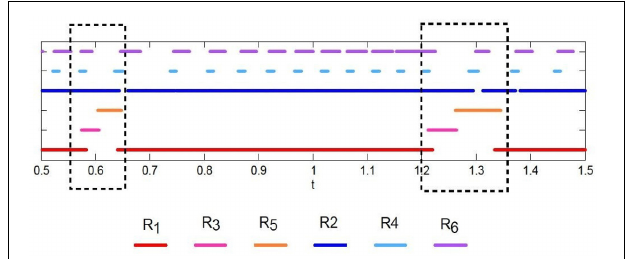
FIGURE 6 | Schematics of the trajectory of a pathological case of GLV equations, when the initial sequence enters a chaotic valley after the violet unit. The system stays in the valley for some time, but ultimately escapes it and resumes the regular SHC switching, see exit at the orange unit.